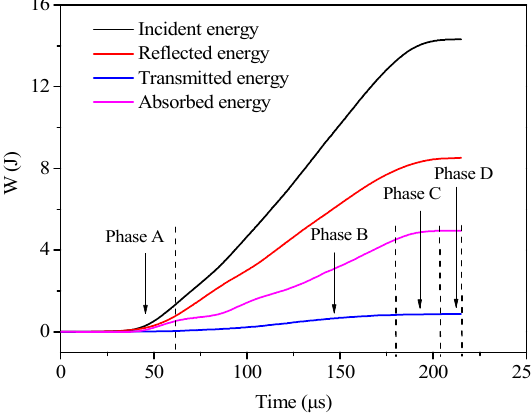
Figure 13. Typical energy curves of specimens.